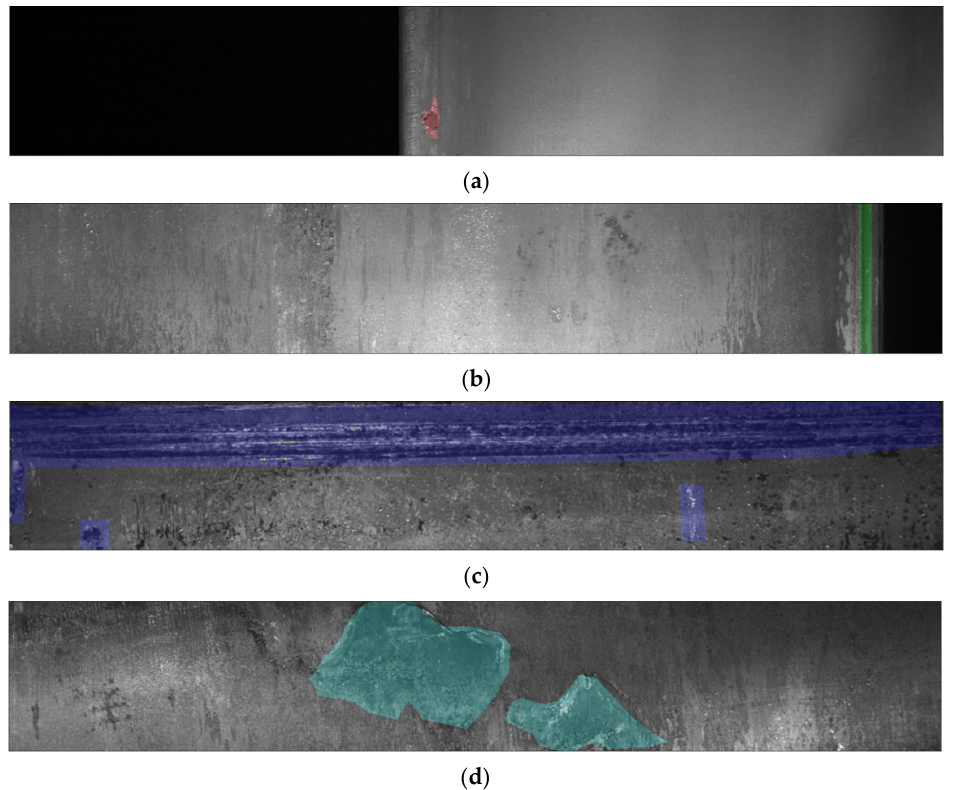
Figure 7. The Severstal steel defect dataset has four defect classes marked with different colors. ( a ) Class 1 has the pitted surface defect condition; ( b ) class 2 has the crazing defect condition; ( c ) class 3 has the scratches defect condition; and ( d ) class 4 has the patches defect